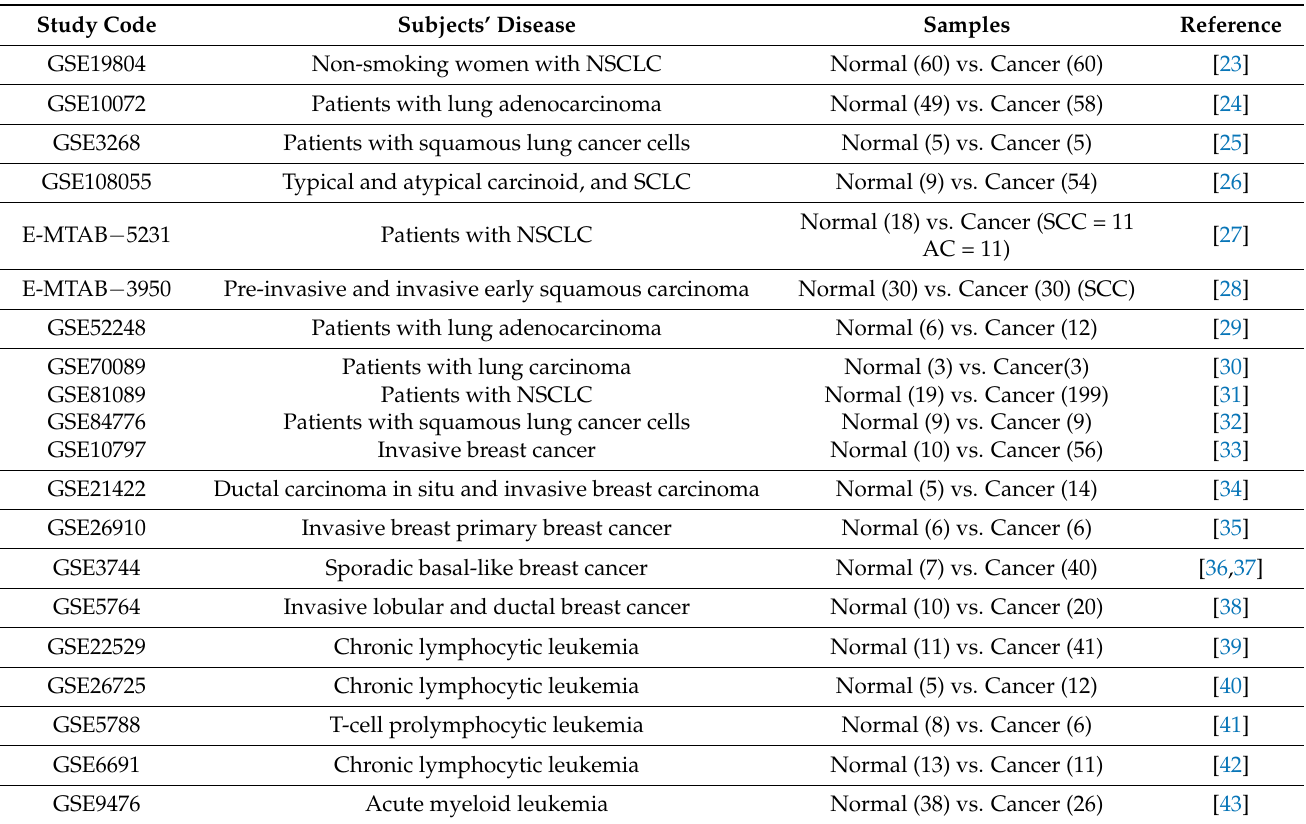
Table 1. Analyzed datasets, each study code, subjects’ disease, and number of